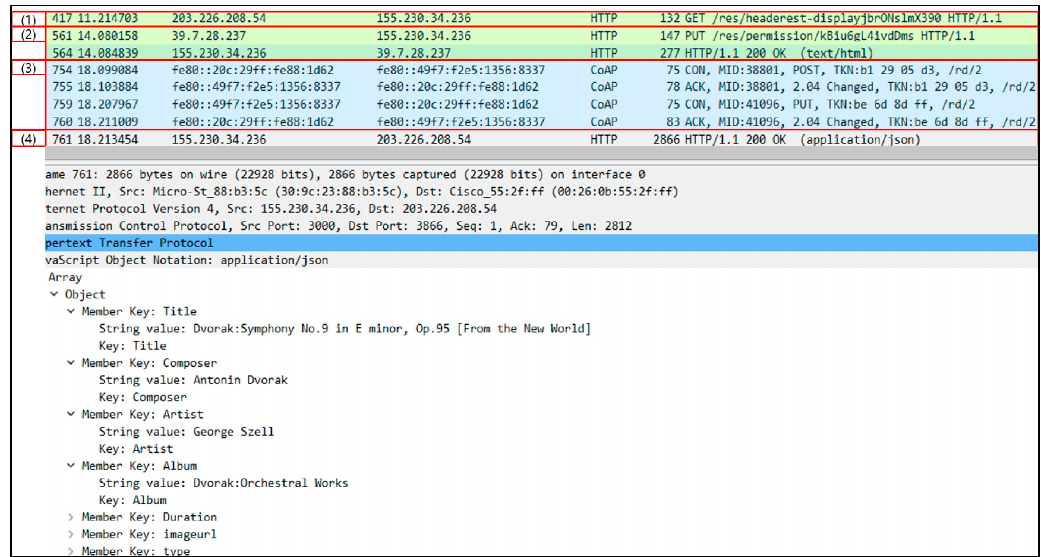
Figure 19. Personal resource control by owner and user.